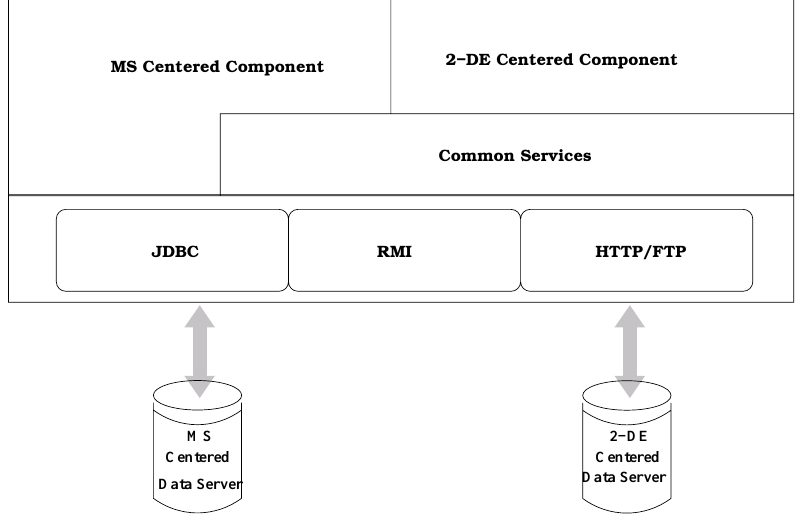
Figure 1: An overview of the PARIS